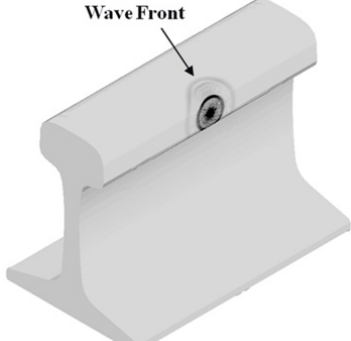
Figura 7: Mappa degli spostamenti dall’approccio agli elementi finiti. Il fronte d’onda è indicato; le regioni nere indicano spostamenti che eccedono il valore di 1  10 -4